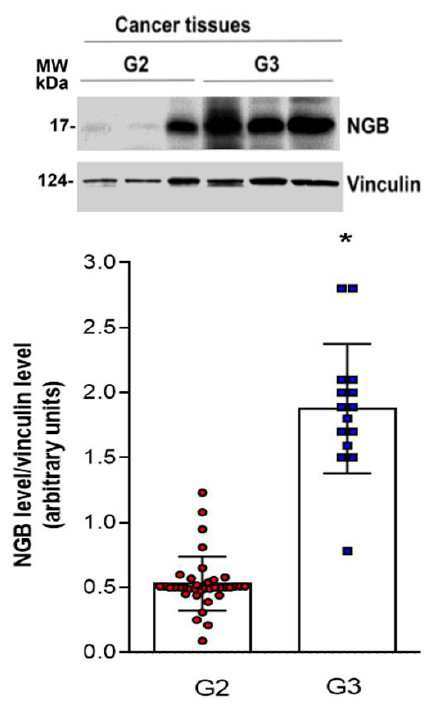
Figure 3. NGB protein levels in tumor samples of breast cancer patients. Representative Western blot images (upper panel) of tissue levels of NGB from G2 and G3 samples and correspondent densitometric analysis of all analyzed tissues ( n = 38, n = 15, respectively) (bottom panel). The amount of protein was normalized by comparison with vinculin levels. Data are means ± SD. p < 0.01 was determined with ANOVA followed by Bonferroni post-test vs. G2 (*) samples.